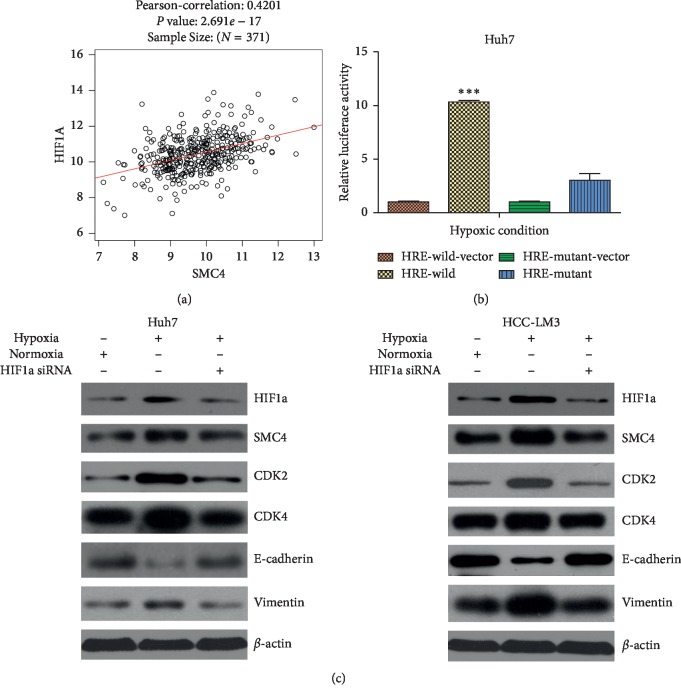
SMC4 was transcriptionally regulated by HIF-1 under hypoxic condition. (a) The result of coexpression analysis between SMC4 and HIF-1a was shown. r = 0.4201, p value = 2.691e − 17. (b) Huh7 cells were cotransfected with HRE-wild-vector or HRE-wild and HRE-mutant-vector or HRE-mutant, and the luciferase activities were examined. The firefly luciferase activity of each sample was normalized to the Renilla luciferase activity. n = 3, ∗∗∗p < 0.0005. (c) Expressions of HIF-1a, SMC4, CDK2, CDK4, E-cadherin, and Vimentin were detected by western blot under hypoxia or normoxia or hypoxia + HIF-1a siRNA.